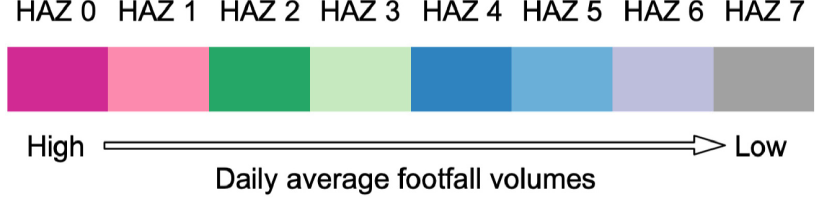
Fig 4. The colour palette used in HAZ delineation